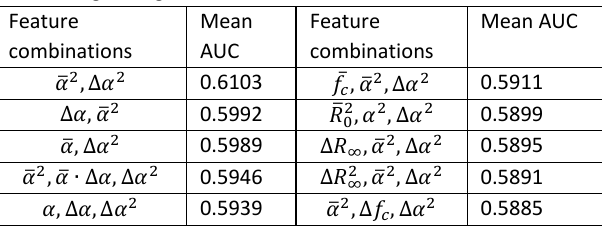
Table.6: Mean AUC values from 100 5-fold cross validation runs with nonlinear logistic regression models